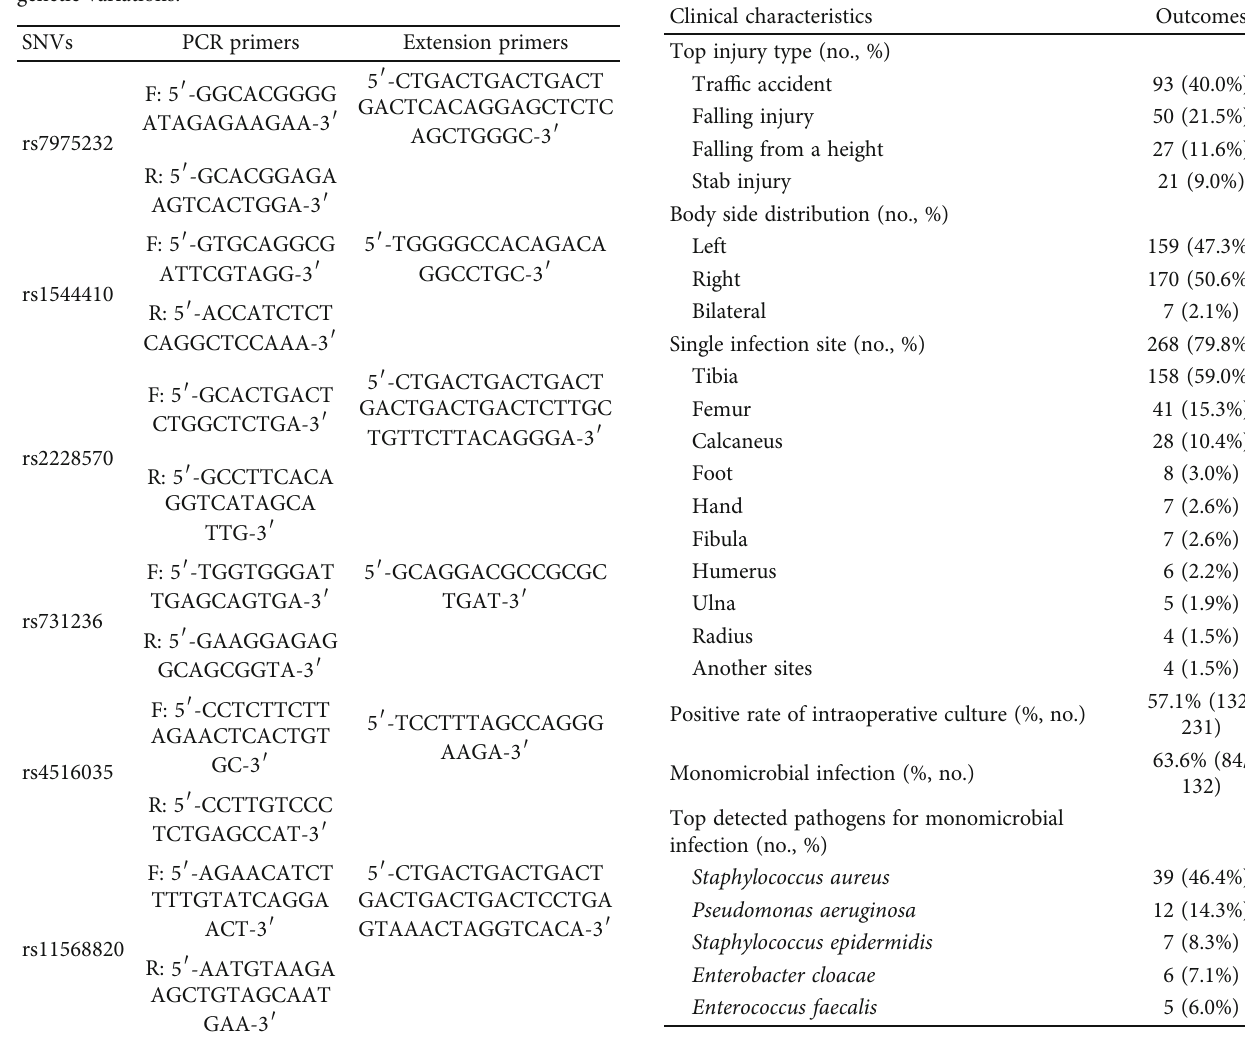
Table 1: PCR primers and extension primers of the six VDR genetic variations.